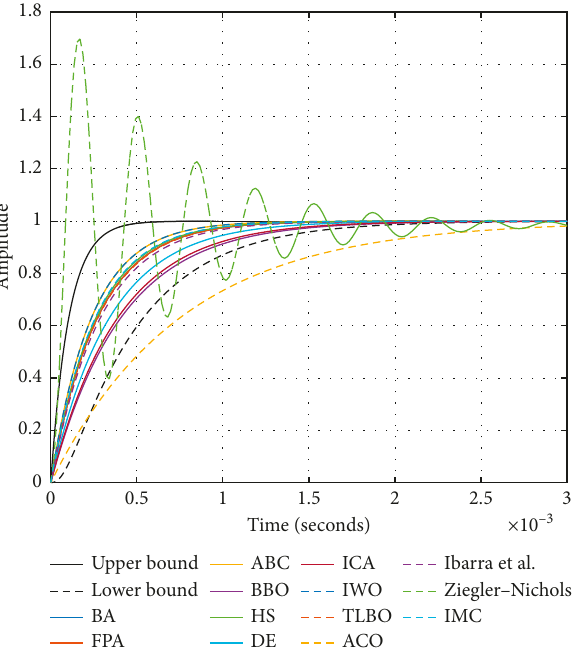
Figure 3: Compared step response of the closed-loop system (the nominal